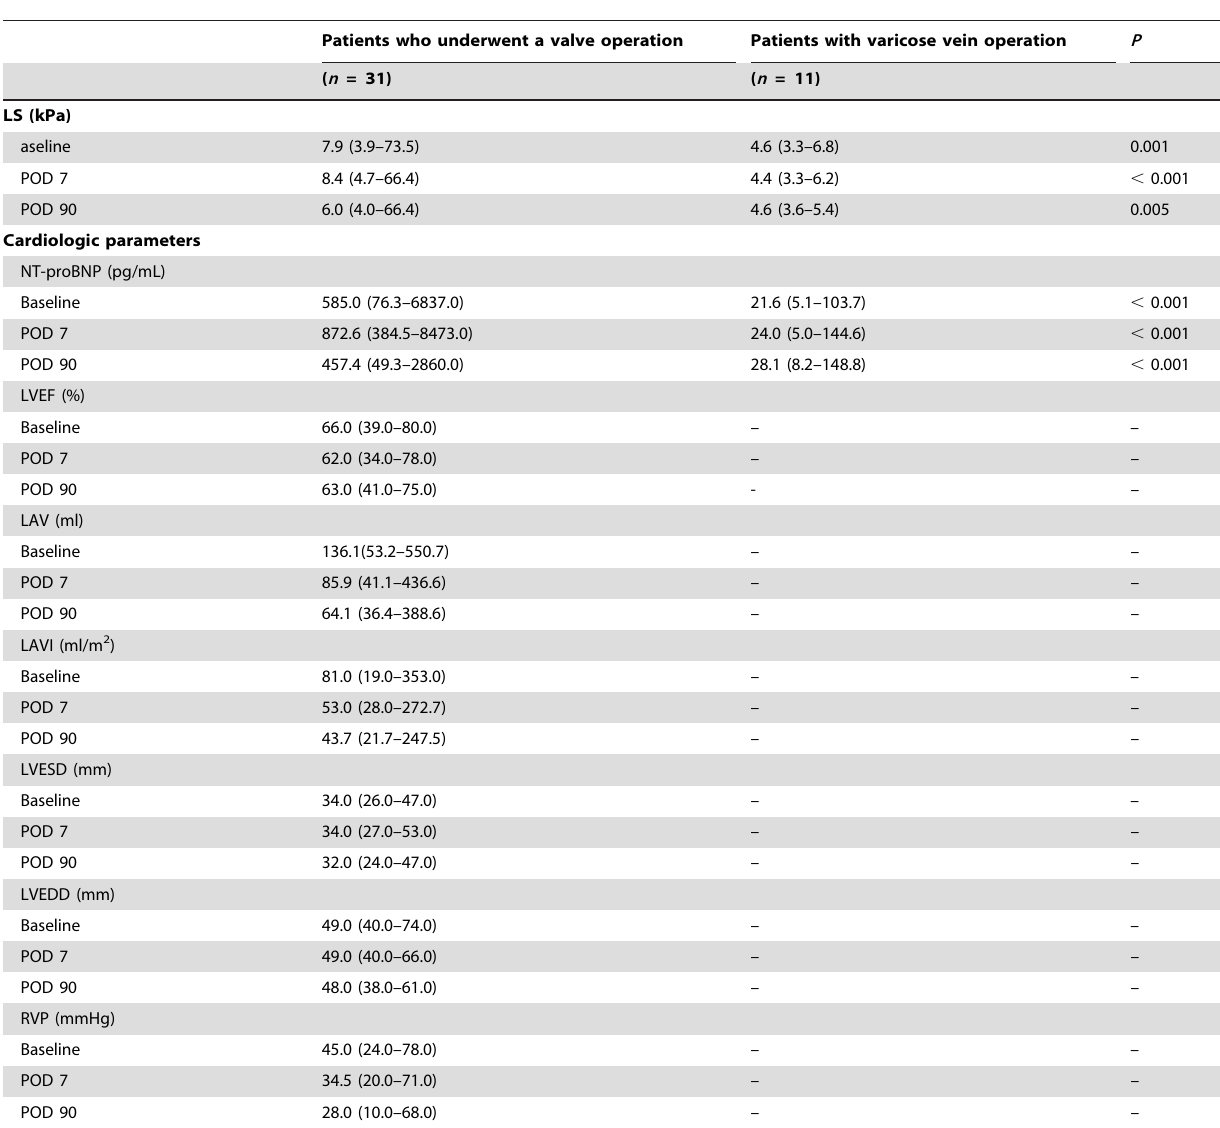
Table 2. Baseline and follow-up LS and cardiologic parameters.